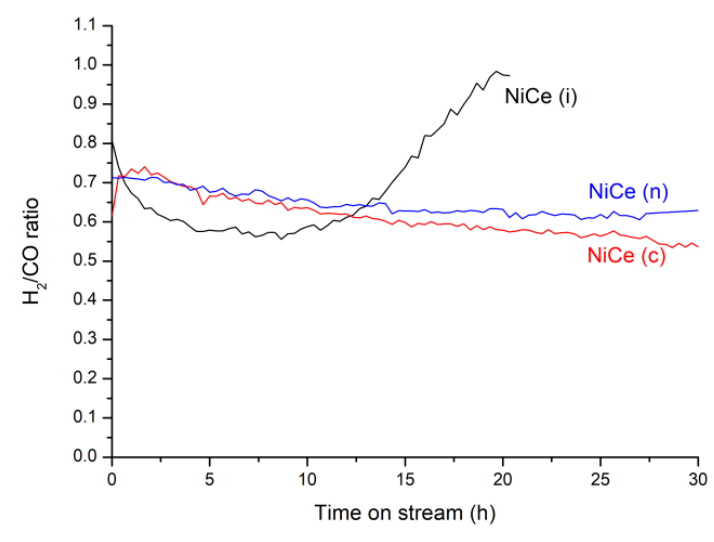
Figure 6. H 2 /CO ratio of three catalysts in reaction conditions.